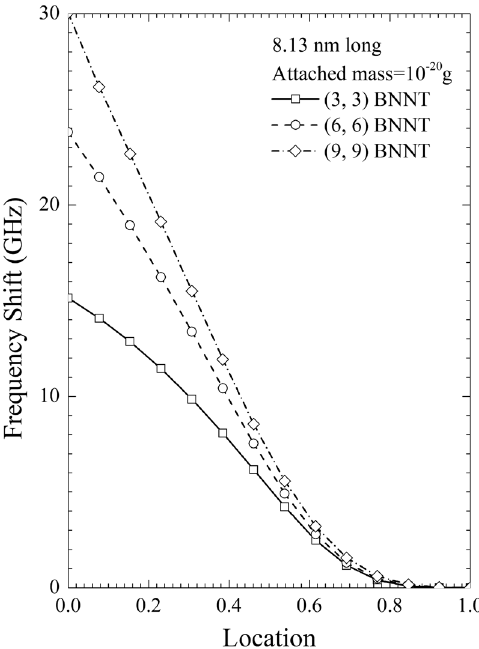
Figure 9: Resonant frequencies for ( 3,3 ) , ( 6,6 ) , and ( 9,9 ) cantilevered SW - BNNT with length 8.13 nm with mass of 10 − 20 g attached at di ff erent locations.